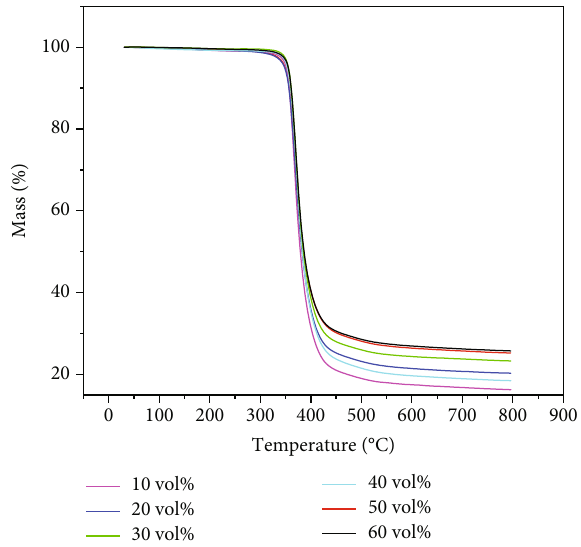
Figure 7: TG curves of the HGM/EP composite insulation materials. The initial thermal decomposition temperatures of the HGM/EP composite insulation materials with HGM volume fractions of 10 vol%, 20 vol%, 30 vol%, 40vol%, 50vol%, and 60vol% were 354.3 ° C, 351.7 ° C, 356.5 ° C, 356.5 ° C, 353.9 ° C, and 356.0 ° C, respectively. The ending thermal decomposition temperatures were 392.1 ° C, 396.3 ° C, 395.5 ° C, 394.4 ° C, 394.5 ° C, and 394.8 ° C, respectively.